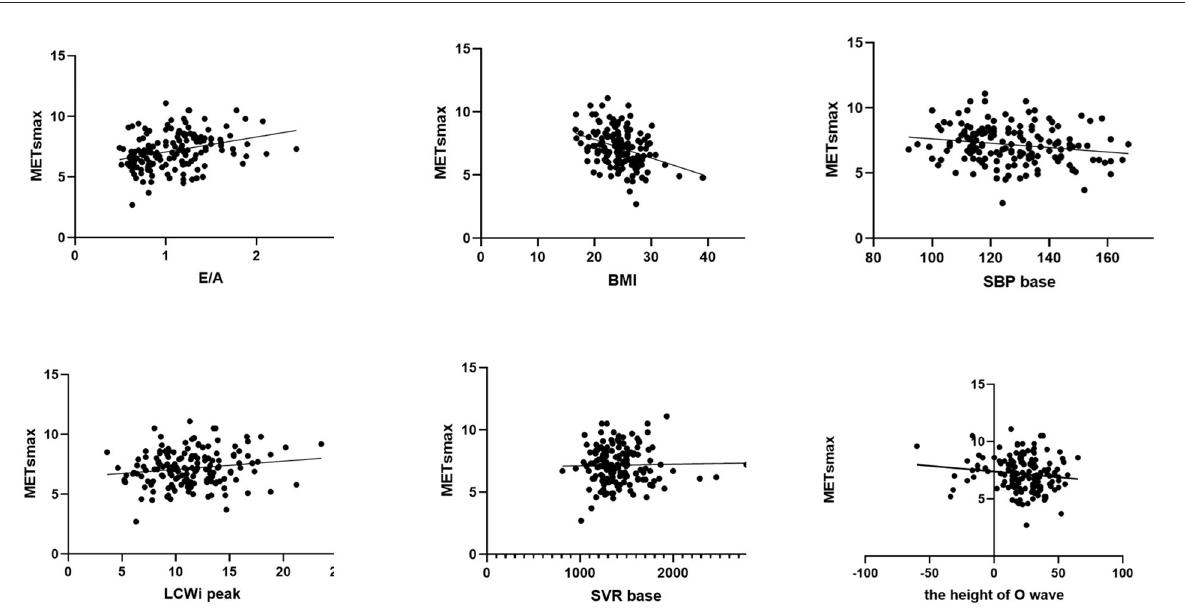
FIGURE2 Scatterplot of simple linear regression equation of E/A ratio, BMI, SBP at baseline, LCWi at peak, SVR at baseline, the height of O wave, and Maximal METs,